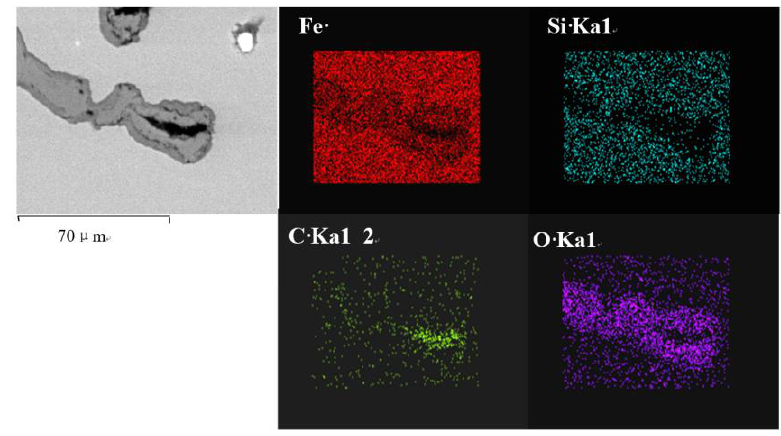
Figure 2. Analysis of area distribution of elements.